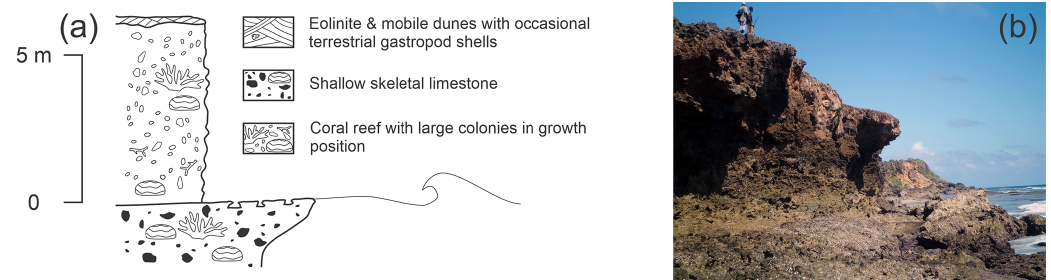
Figure 6. (a) Litholog of emerged reef near Dar es Salaam (modified after Battistini, 1966). (b) Ras Mwanamkuru just south of Ras Kankadya. Exposed Pleistocene reef sitting atop poorly consolidated skeletal limestone. Approximately 10–15m tall. Photo by Davide